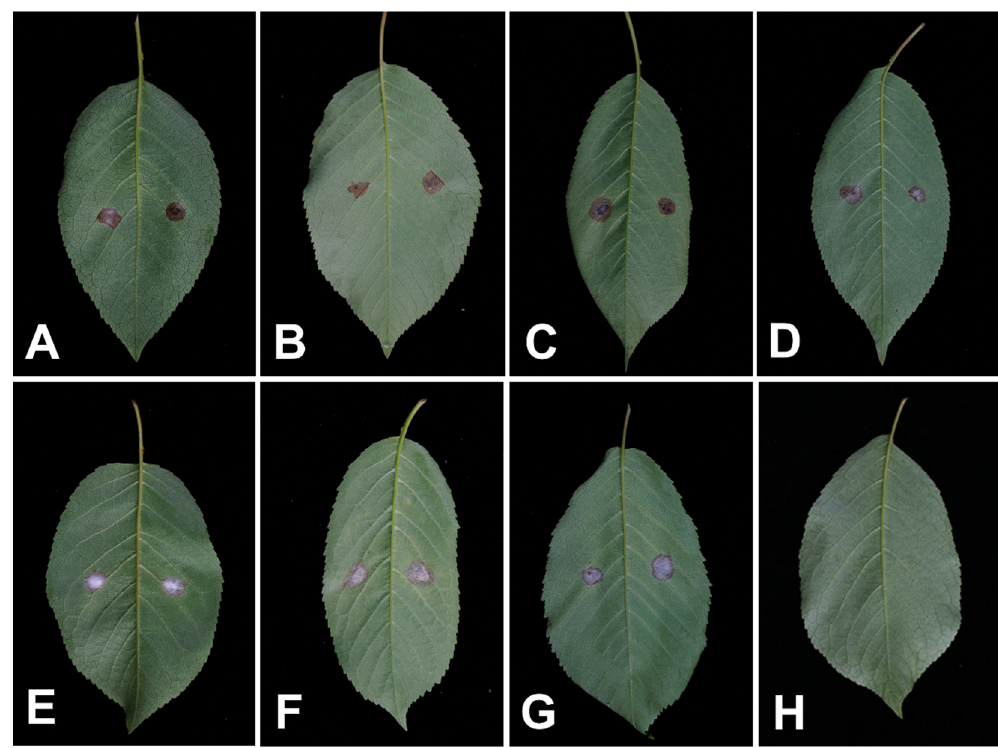
Figure 7. The pathogenicity test of Fusarium spp. on detached cherry leaves three days post-inoculation. ( A – G ) Detached leaves inoculation of F. luffae , F. lateritium , F. compactum , F. nygamai , F. citri , F. ipomoeae and F. curvatum , respectively. Left side of the leaf was wounded before inoculation, right side was unwounded; ( H ) Control. Table 4. Features of colonies and macroconidia for Fusarium species isolated in this study. (lower- case letters indicate the significant differences for lesion diameters ( p < 0.05) Disease Incidence (%) Species